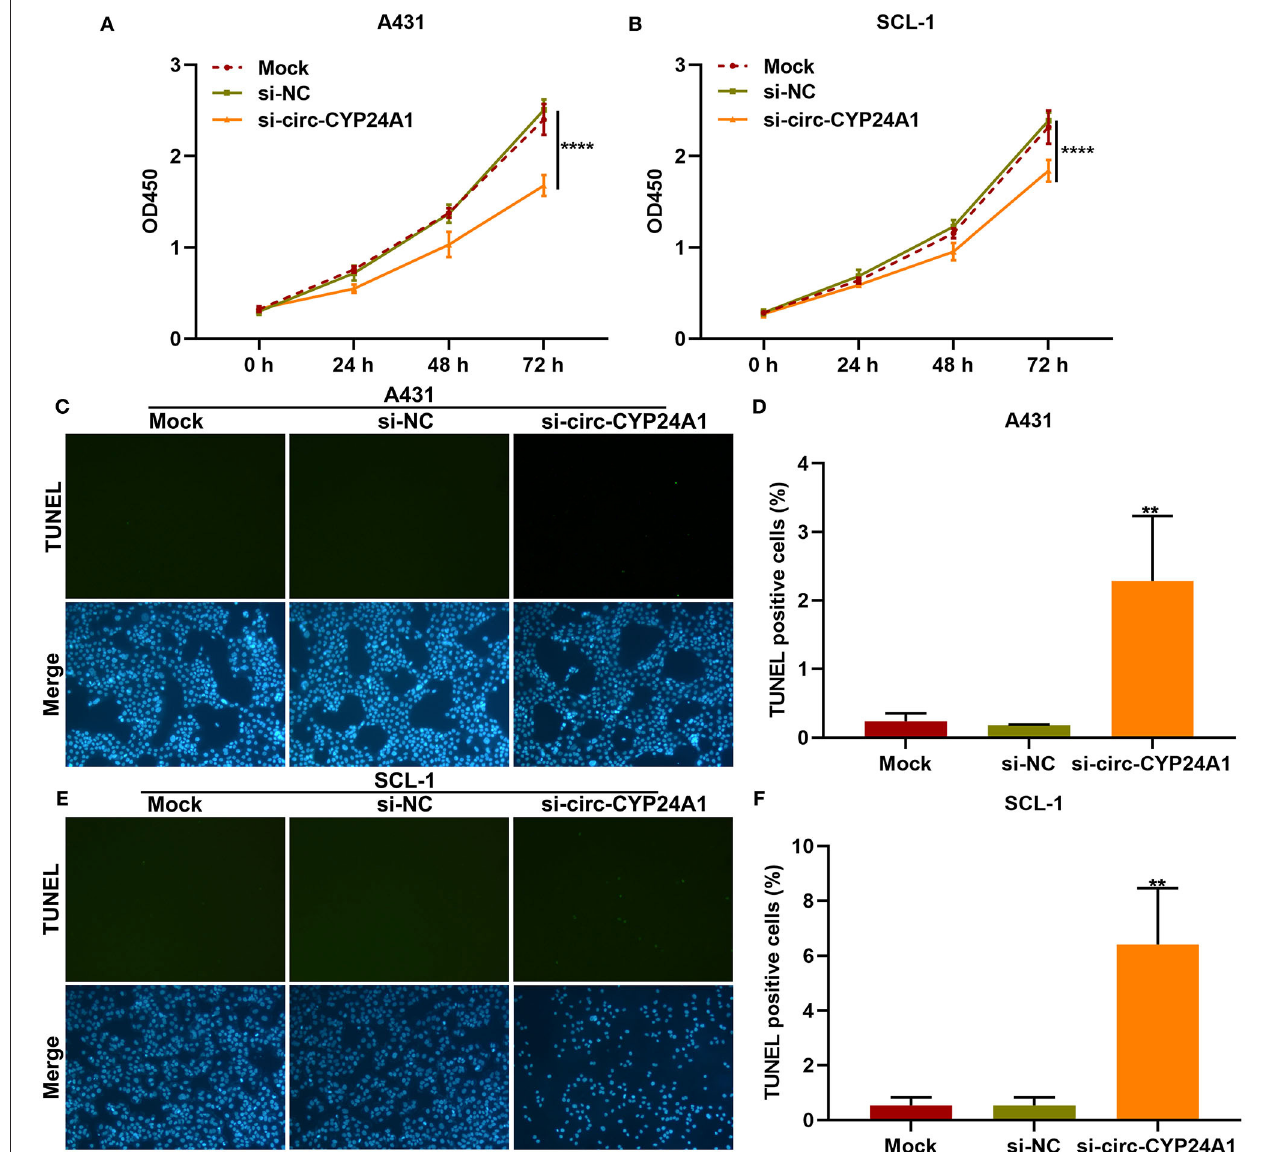
FIGURE 7 | The effects of exosomal circ-CYP24A1 knockdown on proliferation and apoptosis of cSCC cells. (A,B) CCK-8 for the cell viability of A431 and SCL-1 cells incubated with si-circ-CYP24A1-transfected exosomes. (C-F) TUNEL staining for assessing the apoptosis of (C,D) A431 and (E,F) SCL-1 cells incubated with si-circ-CYP24A1-transfected exosomes. ** P -value < 0.01; **** p -value <